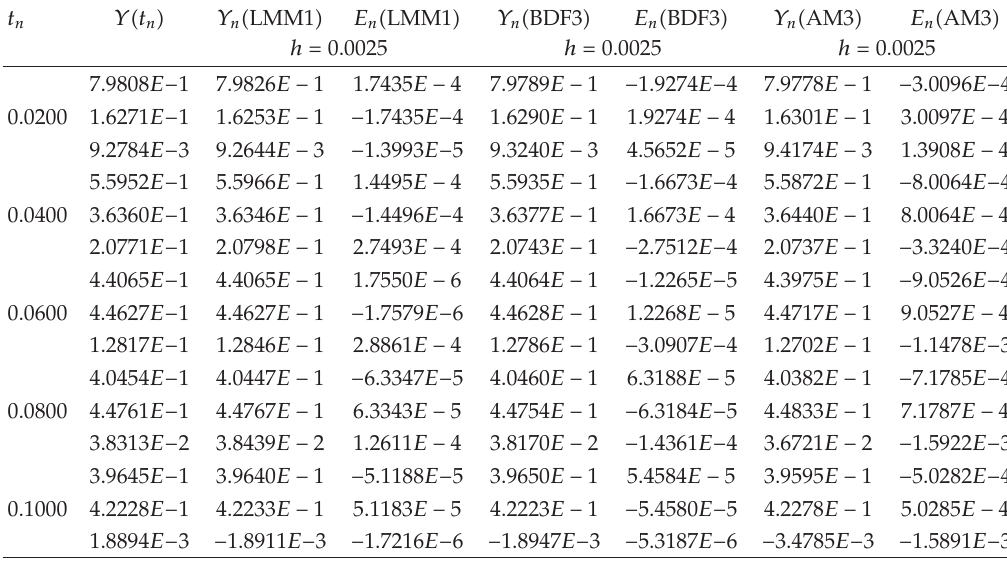
Table 4: Numerical solutions and errors of LMM1, BDF3, and AM3 for (cid:3) 5.1 (cid:4)